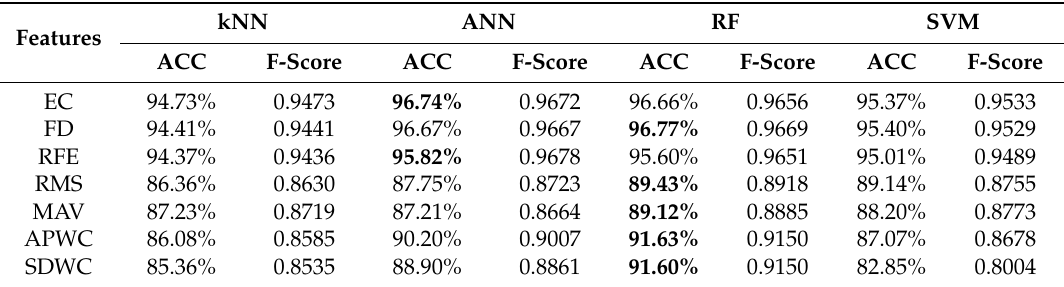
Table 8. Classification performance of machine learning algorithms. ACC is the abbreviation of